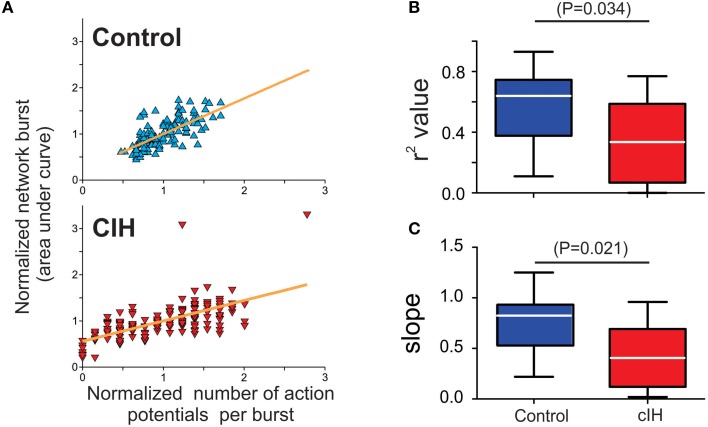
CIH disrupts the predictable linear relationship between action potential generation of individual preBötC neurons and network activity. (A) Individual examples of linear regression analysis run on a single neuron and the respective network burst in slices from a control and a CIH rhythm. Because the CIH reduced the absolute output from a given preBötC neuron, it was important to normalize the number of action potentials generated from a given preBötC neuron to the mean number of action potential produced during the network burst to accurately assess whether CIH changed the behavior of an individual neuron relative the corresponding network burst. (B) The coefficient of determination value (r2) is larger in the control group compared to CIH group (C) Similar to r2, the slope value is larger in the control group compared to the CIH group.